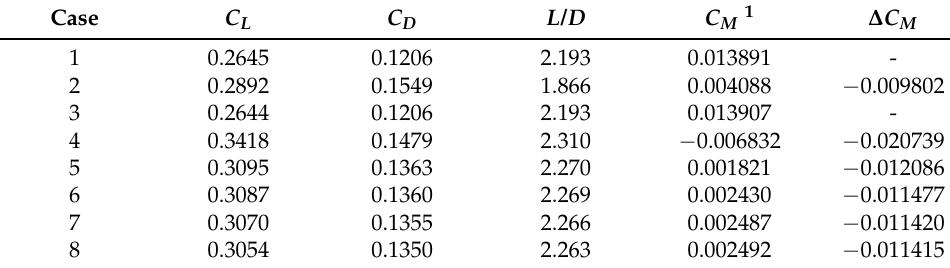
Table 5. Computational Results of Aerodynamic